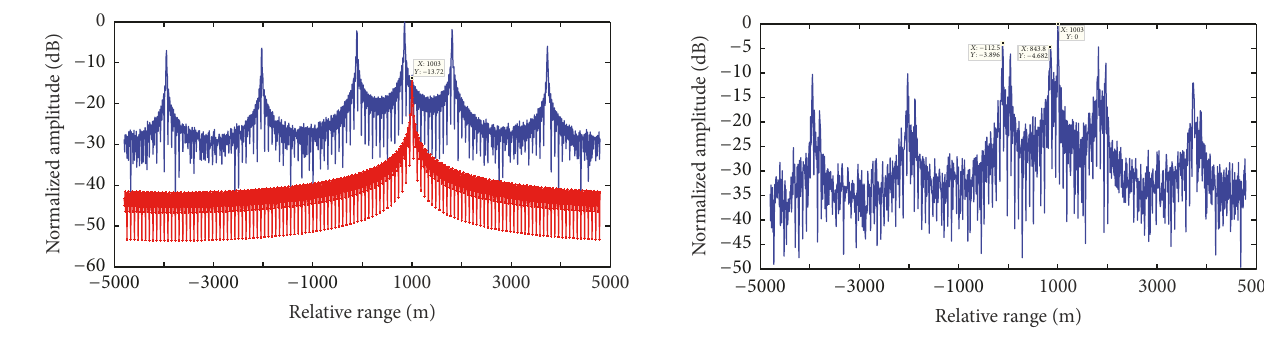
Figure 6: The jamming suppression result using 𝐻(𝑓) ( 𝑇 𝑠 = 2 𝜇 s).